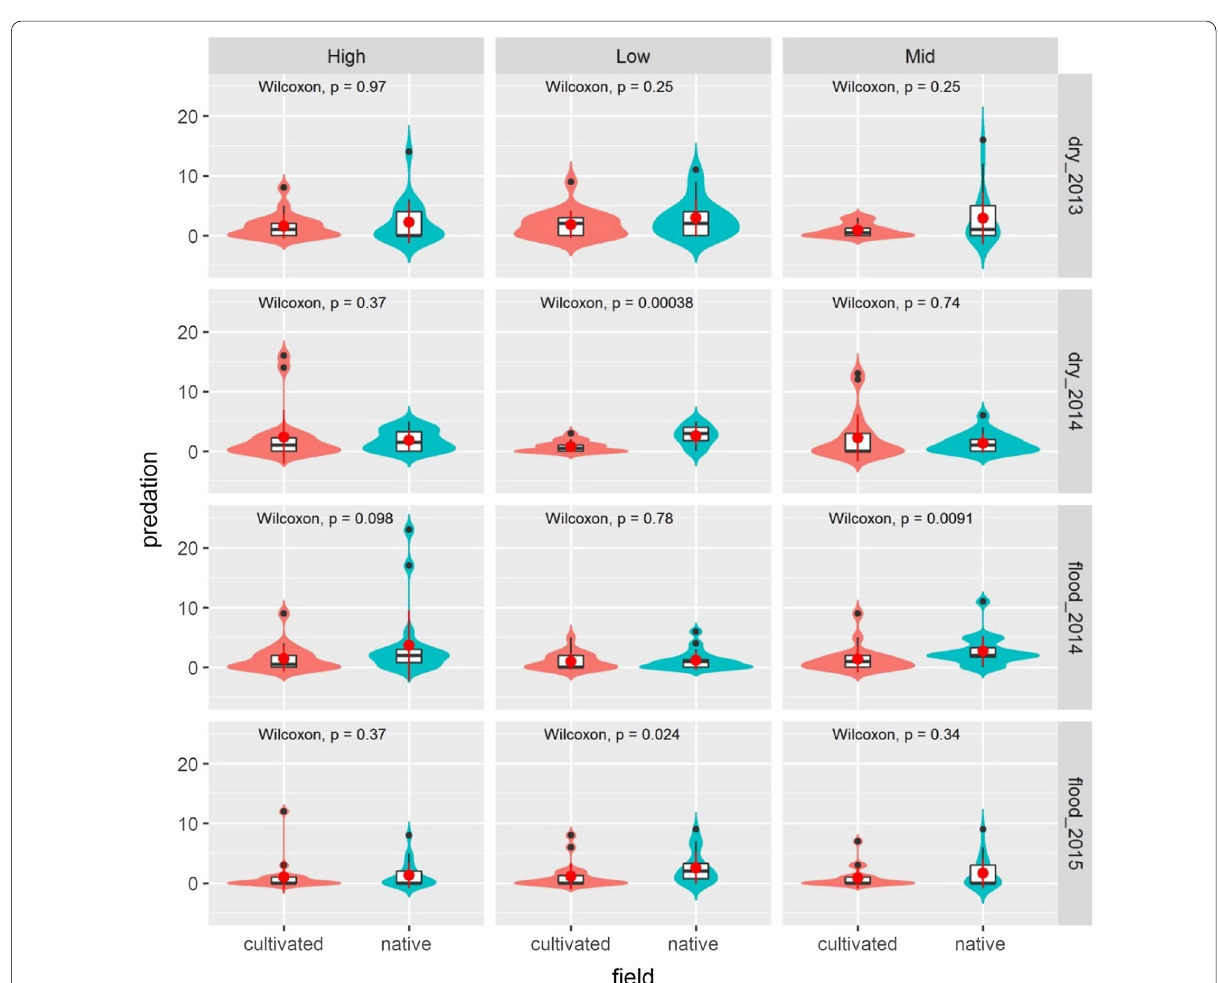
Fig. 5 Differences in number of seed predated between type of grasslands (native and cultivated), by seasonal flood disturbance (post-flood and post-dry disturbance) and topographical gradient (low, mid, high), Pantanal wetland. We classified the topographical conditions into three levels: (1) low–longer duration of flood; (2) mid–intermediate level; and (3) high–short duration of